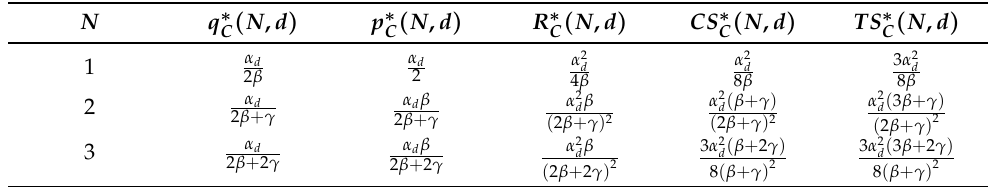
Table 5. Equilibrium quantity, price, profit, consumers’ surplus and total surplus with one, two and three active